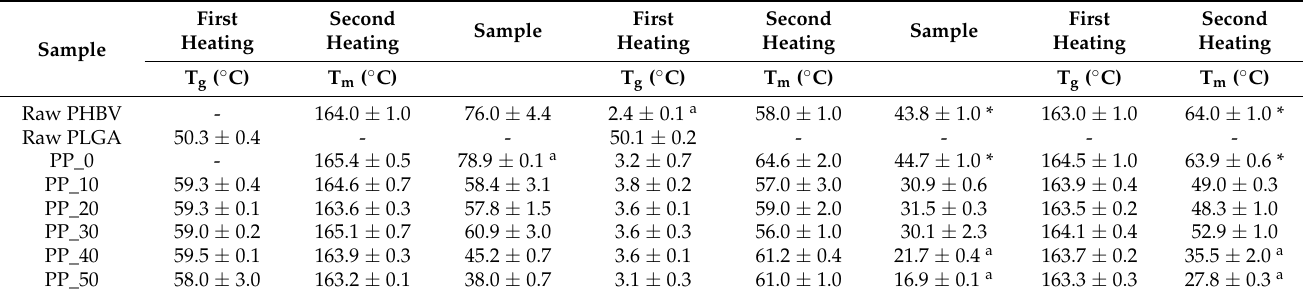
Table 4. Data relevant to the thermal characterization by DSC